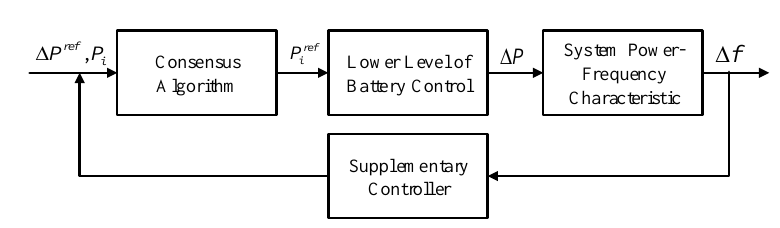
Figure 2. System control process.